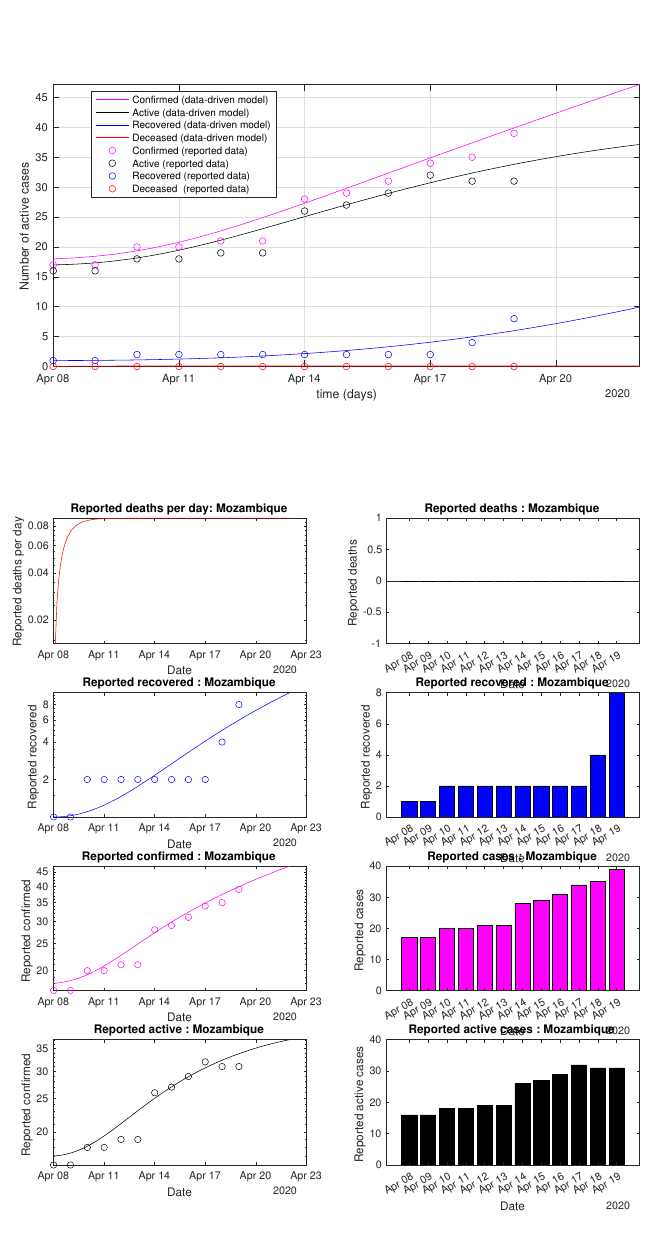
Figure 76. Mozambique: data vs.